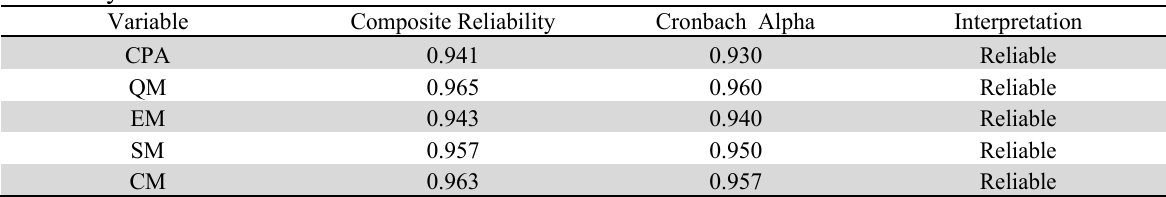
Reliability Test